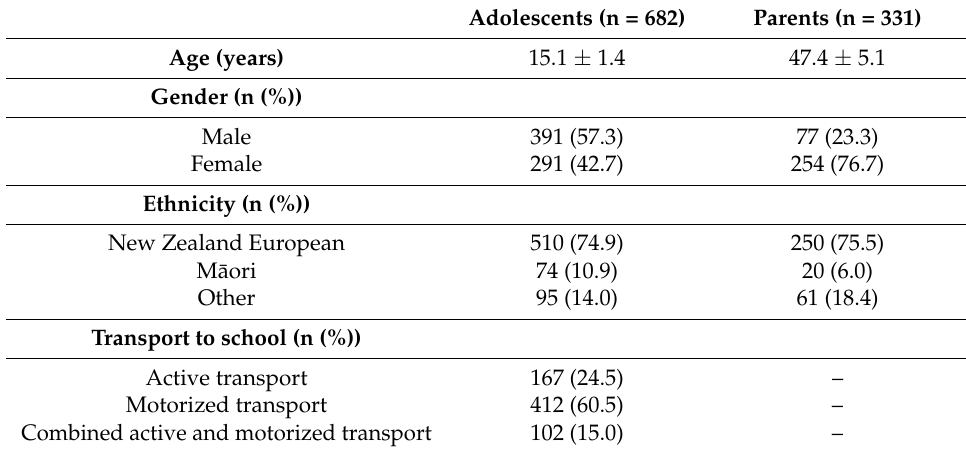
Table 1. Sociodemographic characteristics of the study participants.